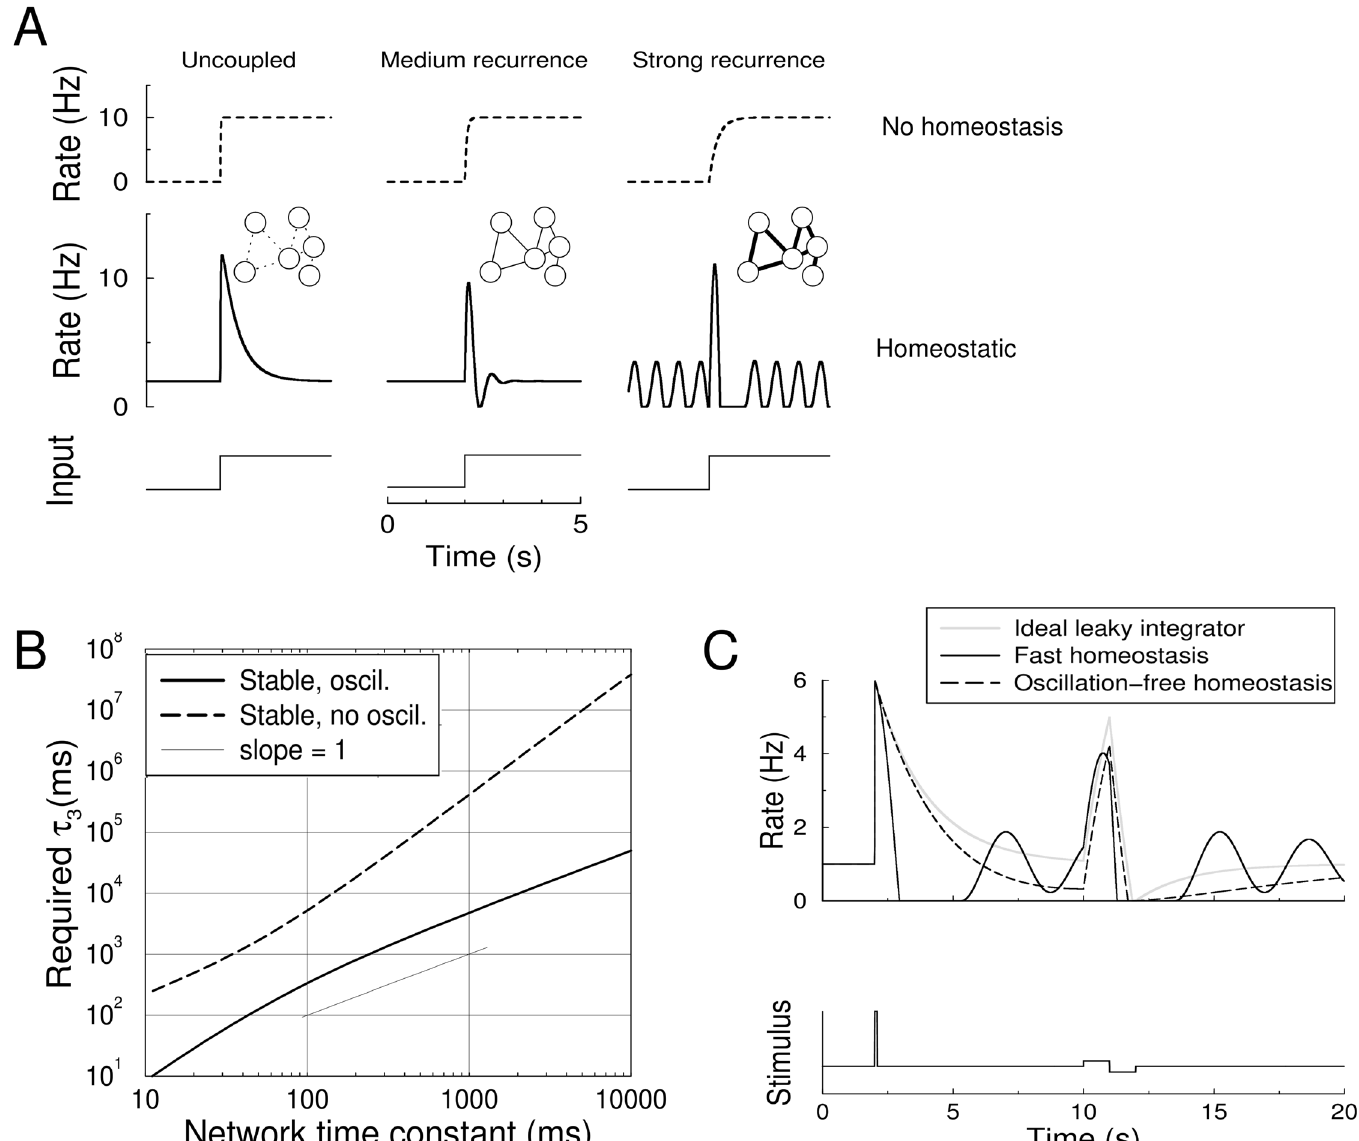
Fig 2. Homeostasis can destabilize activity in otherwise stable networks. A) Activity in a homeostatic network with varying levels of recurrence, but identical homeostatic parameters ( τ 1 = 10ms, τ 2 = 50ms, τ 3 = 500ms). Without homeostasis even the strongly recurrent network is stable (top row). With homeostasis, although the network in stable in the absence of synaptic coupling (left), with increasing recurrence the network shows increasing oscillatory activity (middle, w m = 0.8), and becomes unstable for strong recurrence, leading to unabating oscillations (right, w m = 0.95). B) The requirements on the homeostatic time-constant as a function of the recurrence of the network, expressed in terms of the network time-constant, which equals τ 1 /(1 − w m ). Shown are the minimal value of τ 3 to ensure stability, potentially with damped oscillations (solid curve) and the minimal value of τ 3 for a stable firing rate without oscillation (dashed curve). C) The interference of homeostatic control with a neural integrator. The response of an ideal leaky-integrator with 1s time-constant (gray curve) to a pulse at 2s, and a bi-phasic pulse at 10 s. The response of a stable, but oscillatory homeostatic network is very different from the non- homeostatic case (black curve, τ 3 = 7s). Only when the homeostasis is slow enough to be oscillation-free, the response approximates that of the ideal integrator (dashed curve, τ 3 = 420s).